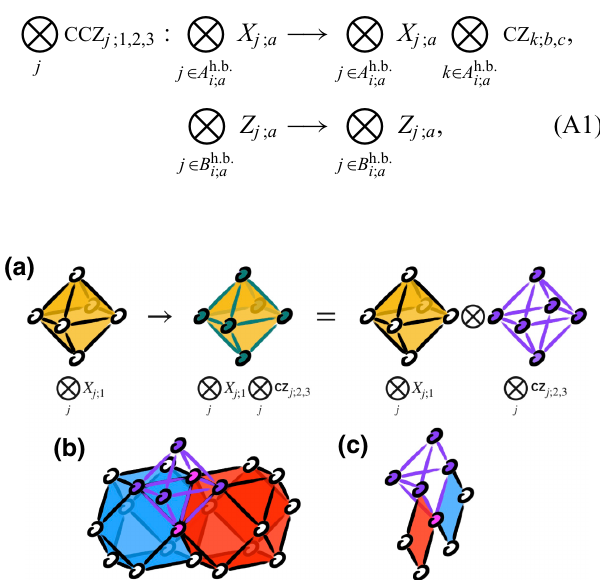
FIG. 36. An example of the action of a transversal CCZ gate on the X stabilizers of a code. (a) We demonstrate the action of a transversal CCZ gate on the yellow weight-6 stabilizers in code block 1. Under the action of CCZ , Pauli X on one qubit is mapped to a product of X and CZ on the other two code copies. This product is represented in green. We can break this product into two components, one comprised of the original X stabi- lizer and a resulting tensor product of CZ on the other two code blocks, which is represented in purple here. (b) The action of CZ on the qubits in the octahedron will result in a logical iden- tity in the bulk, as the support of this operator mutually overlaps with two qubits from the intersection of any two red and blue weight-12 stabilizers—these qubits are symbolized in pink. (c) On the boundary, the overlap of the weight-5 CZ operator will only overlap with a single qubit from the intersection of the red and blue faces—as such, this does not satisfy the requirements to be a logical identity